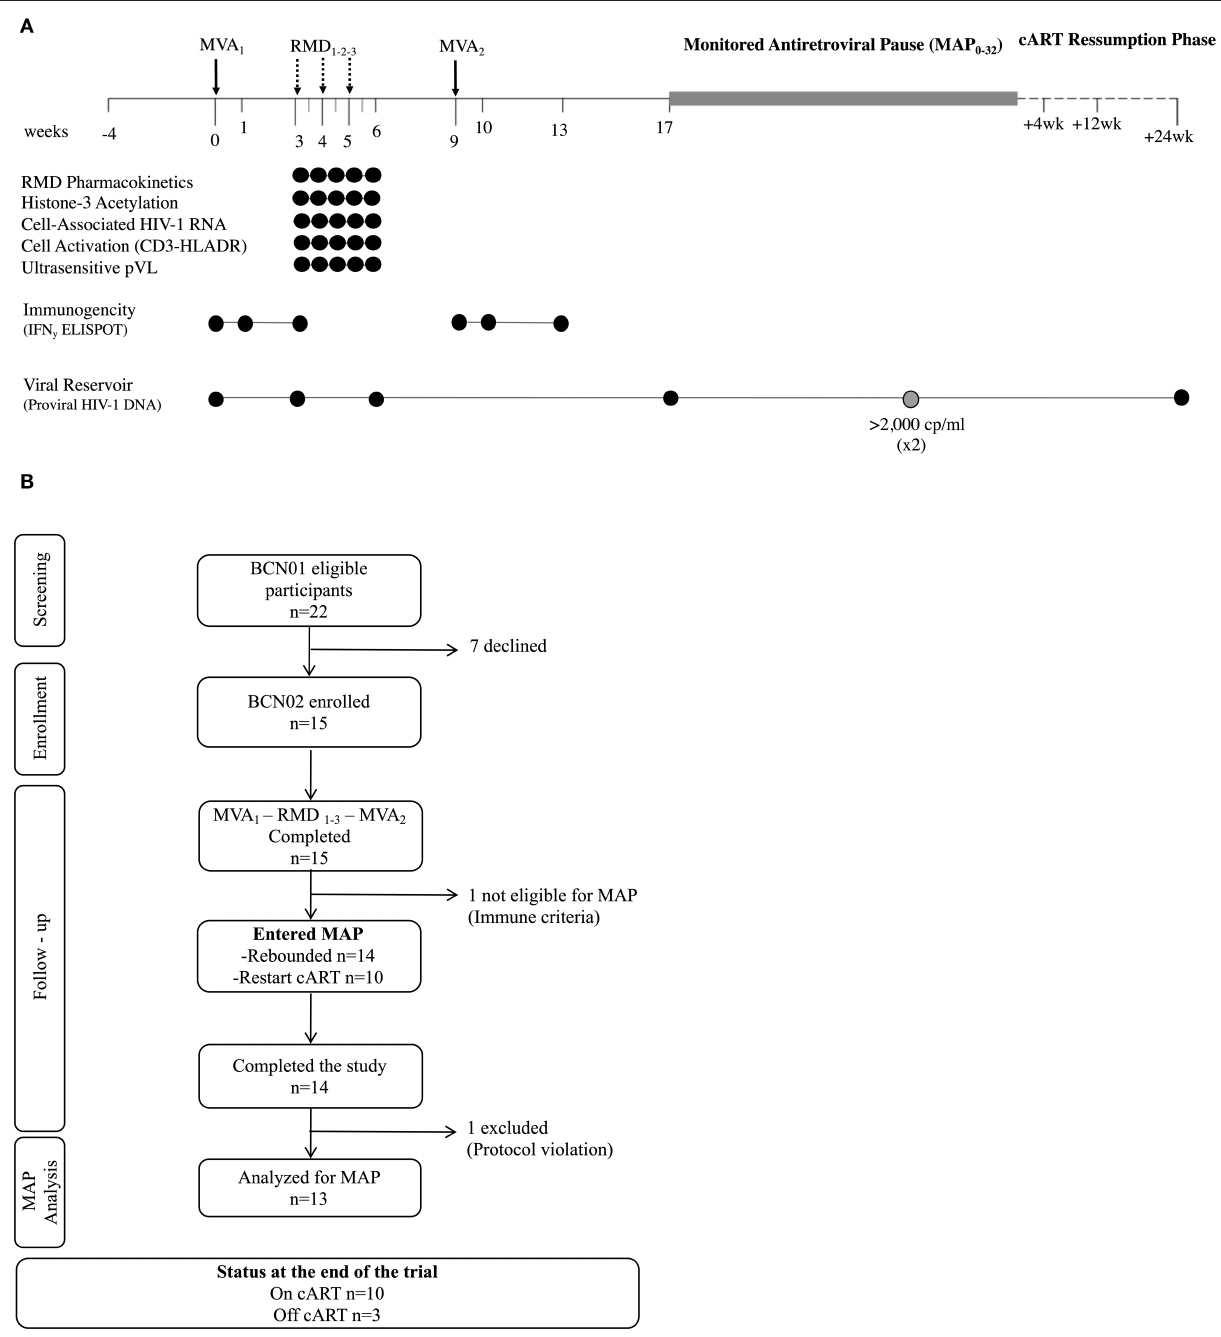
to compensate for any potential impairment in the previous vaccine-induced response caused by RMD. Following RMD prescription information, participants received